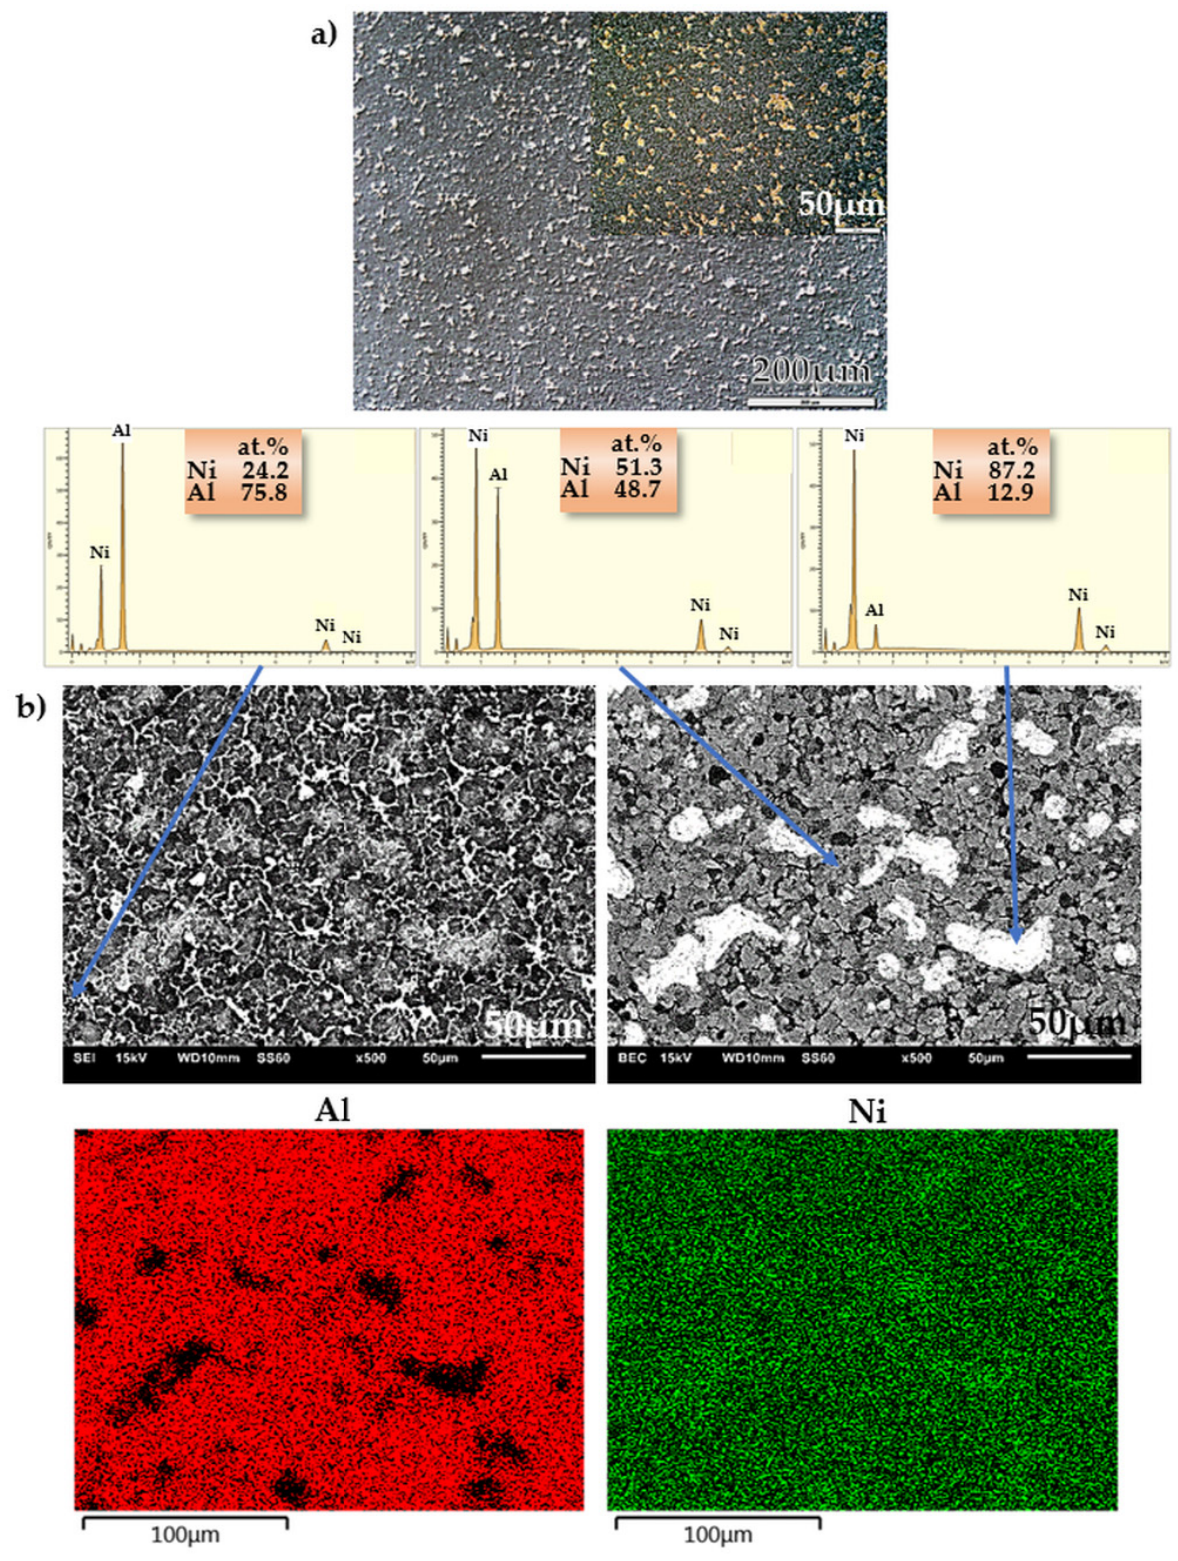
Figure 5. Microstructure of NiAl50 alloy: ( a ) optical microscope, Nomarski contrast; ( b ) SEI—secondary electron image—( left ) and BEC—backscattered electron composition—( right ) SEM micrograph, point- and-map analysis of the distribution of individual microstructural